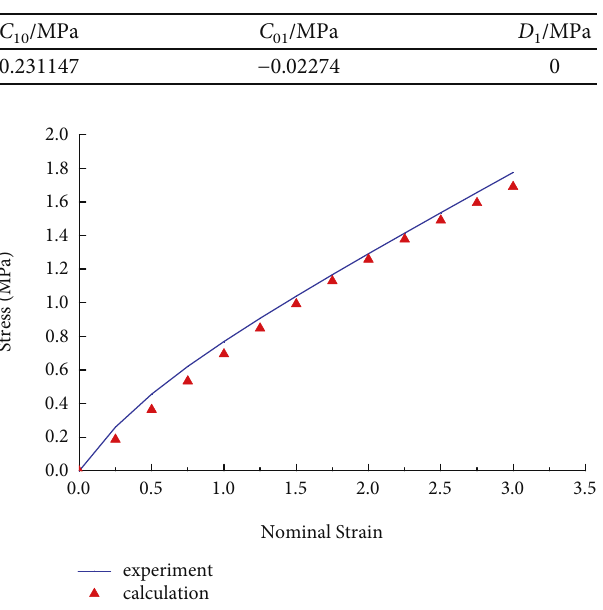
Table 2: Values of C